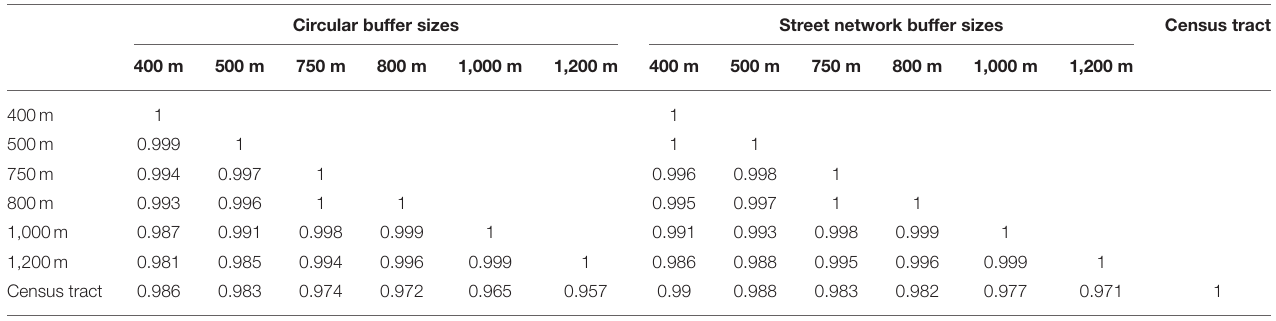
TABLE 2 | Pearson’s correlations of neighborhood socioeconomic status index values at various circular and street network buffer sizes, and census tract level; n = 1,600 * from the National Cancer Institute’s FLASHE Study. Circular buffer sizes